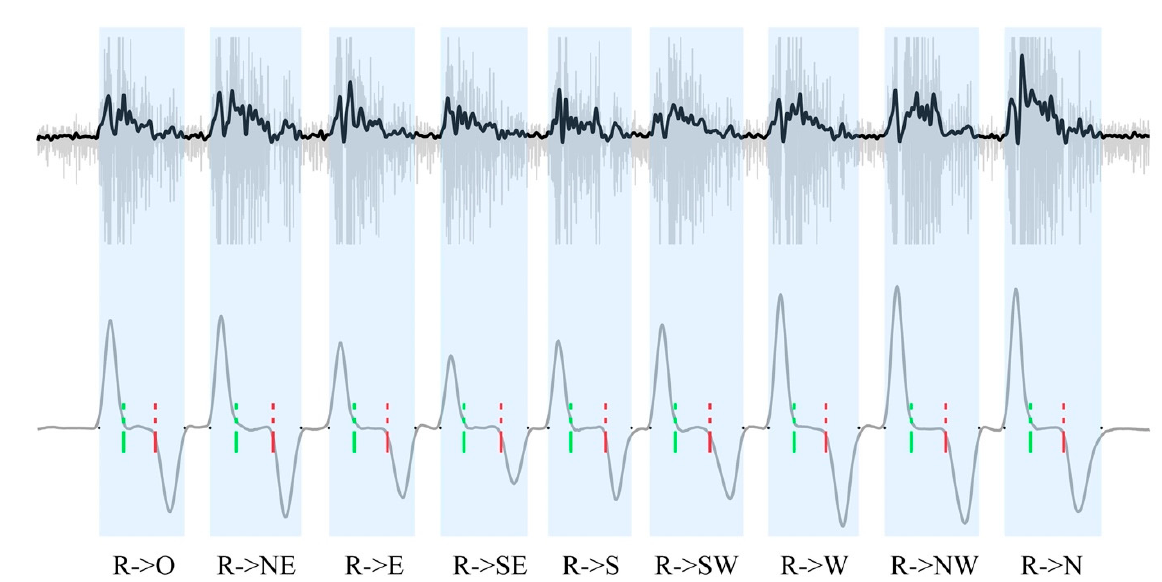
Figure 3. The EMG signal (raw and filtered, upper panel) and velocity profile (lower panel) of a typical subject. The shaded area indicates a full task (reaching and return to the starting point). The green vertical dashed lines indicate the ending time of the forward phase, i.e., the phase from the reference R to the target. The red dashed lines indicate the beginning of the backward phase. A pause lasting one second was performed when reaching the target markers (between each green and red line).